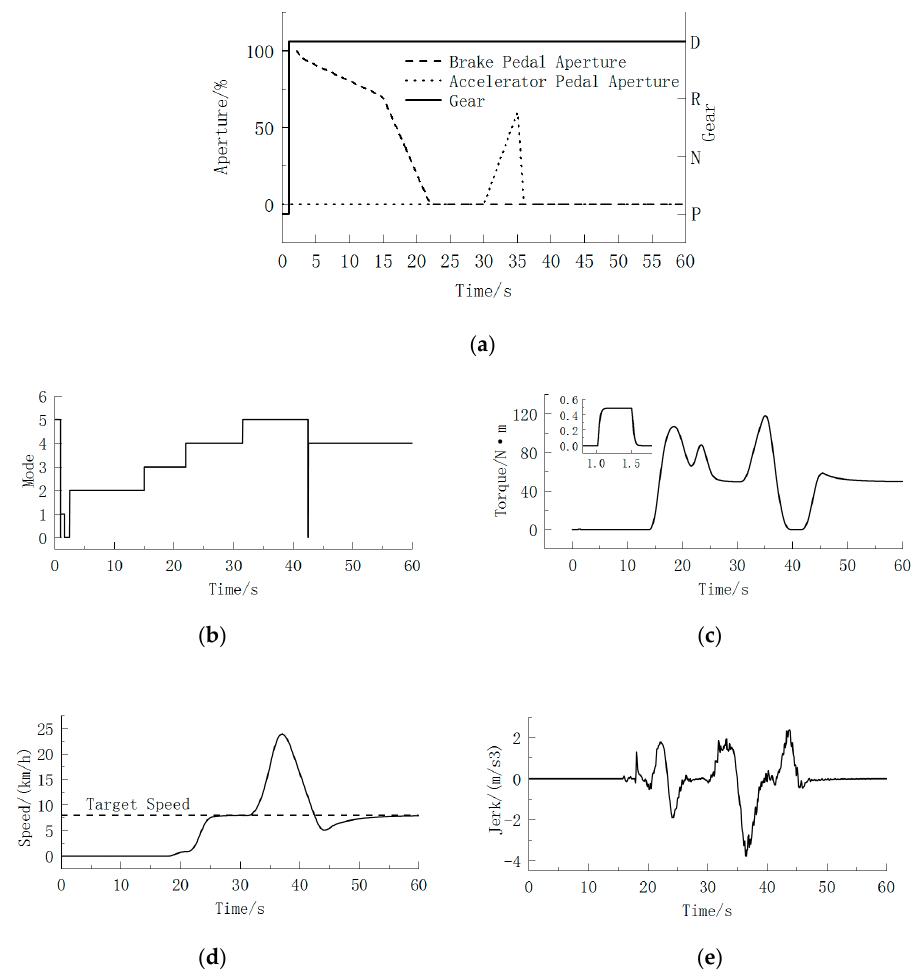
Figure 13. Control Process of 9% Inclination Condition: ( a ) Driver Intention; ( b ) Mode Switching Diagram; ( c ) Curve of Motor Output Torque; ( d ) Curve of Vehicle Velocity; ( e ) Curve of Jerk.